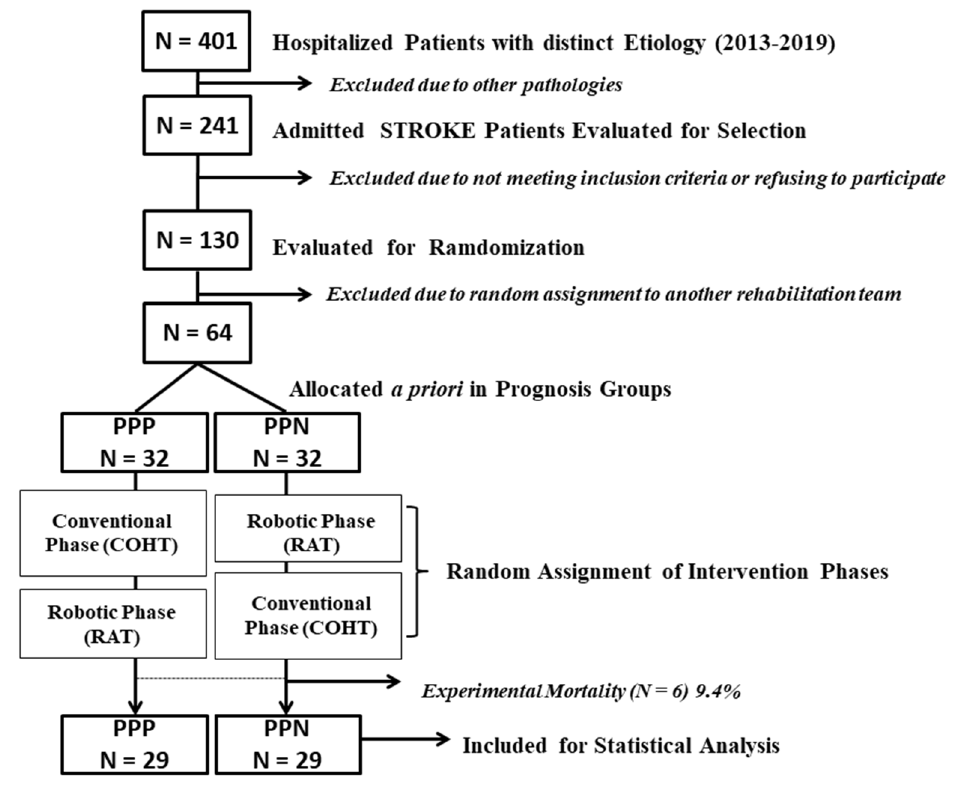
Figure 1. CONSORT flow chart identifying the phases of this study: Selection, recruitment, monitoring, and analysis processes are shown. COHT: conventional hand-specific occupational therapy; PPP: positive prognostic profile group; PPN: negative prognostic profile group; RAT: robot-assisted therapy.